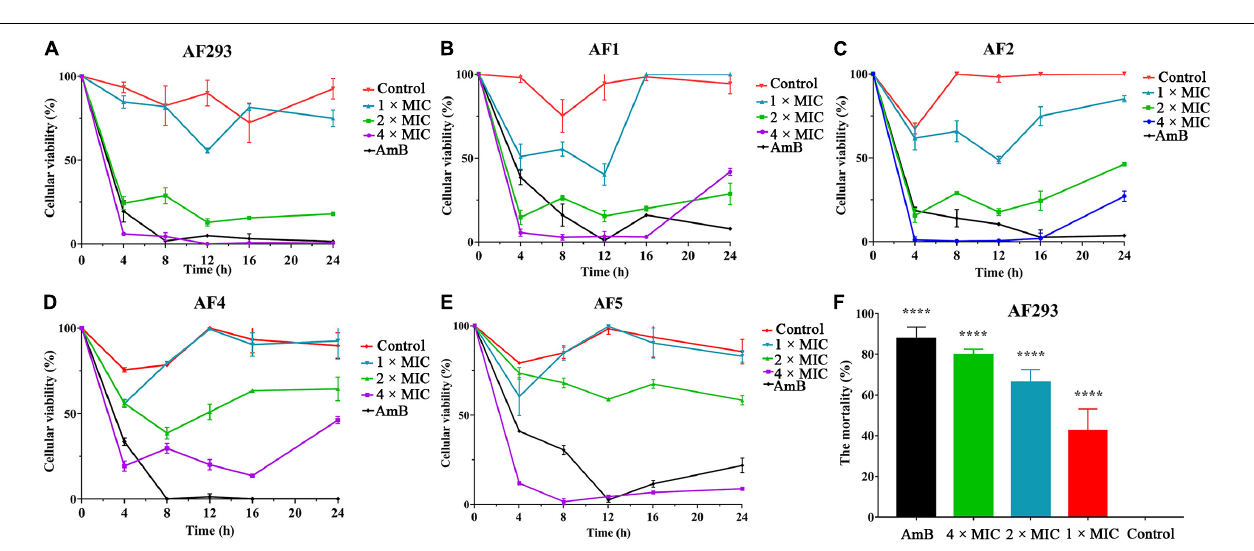
FIGURE 4 | Sodium new houttuyfonate (SNH) has fungicidal activity against A. fumigatus . (A–E) Time-kill curves of 1 × , 2 × , 4 × , and 8 × MIC SNH against A. fumigatus AF293, AF1, AF2, AF4, and AF5 strains. Readings of colorimetric XTT reduction assays at 492 nm are expressed as the percentage cellular viability of the control. (F) The mortality of AF293 was analyzed with PI staining after treatment with SNH at 1 × , 2 × , and 4 × MIC. AF293 treated with 8 µ g/mL AmB and no drugs were used as the control groups. Results represent the average of three independent experiments ± SD, and the level of statistical significance was set at * P < 0.05, **** P <